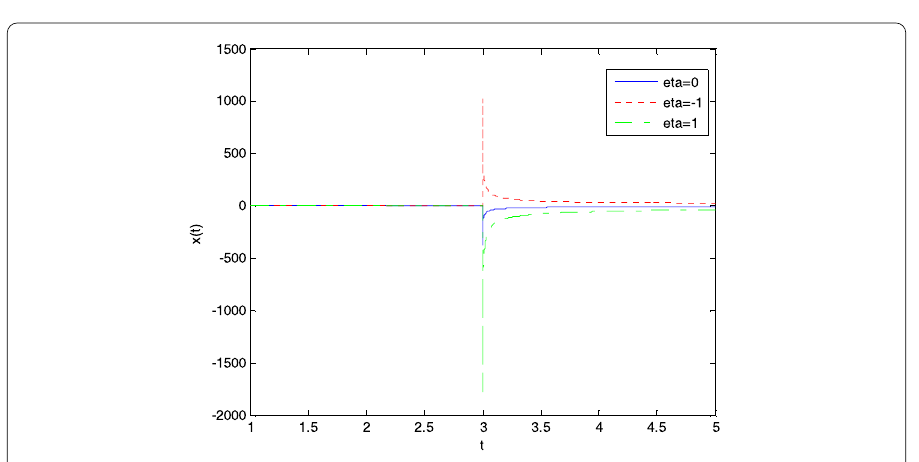
Figure 7 The solution trajectory of system (5.2) with ρ = 1